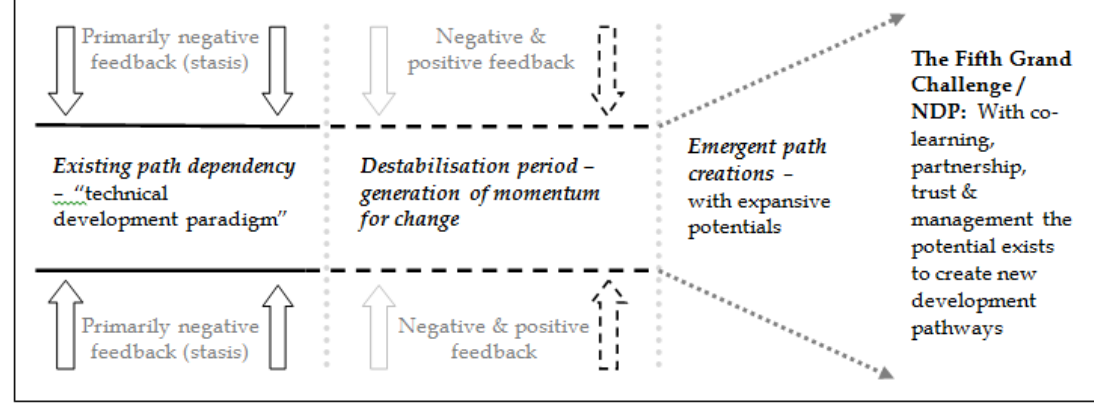
Figure v: Epistemological path breaking and path creation. Source: adapted from Garud et al .,